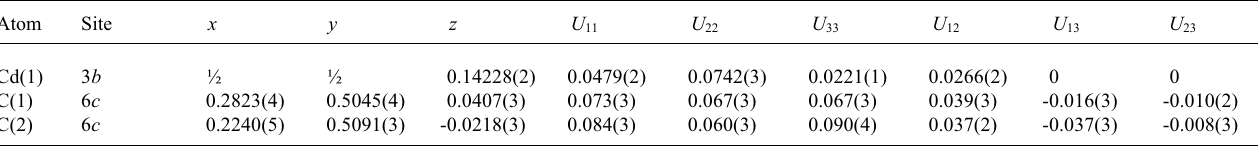
Table 3. Atomic coordinates and displacement parameters (in Å 2